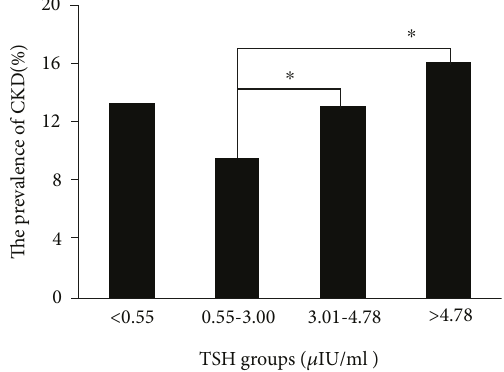
Figure 3: The prevalence of CKD in 5936 participants in type 2 diabetes without overt thyroid dysfunction according to TSH quartiles. ∗ p < 0 05